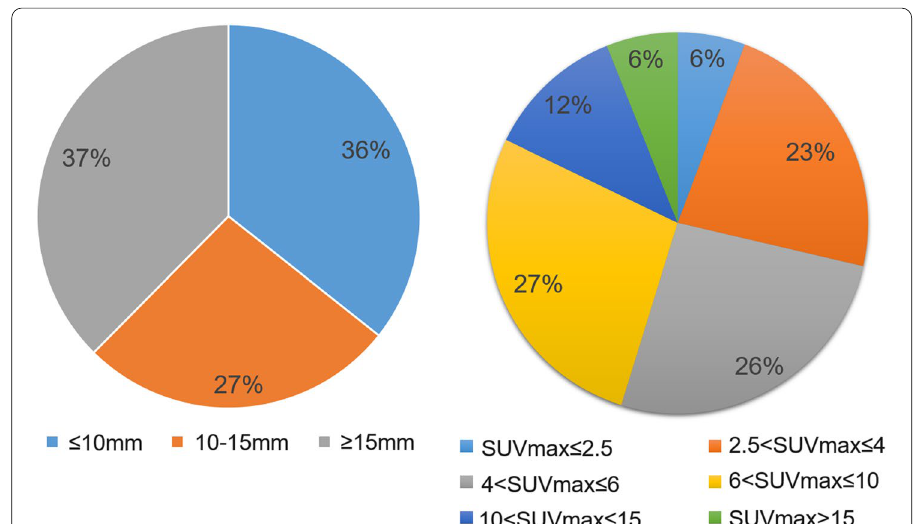
314). Left: Diameters of the lesions measured in computed =